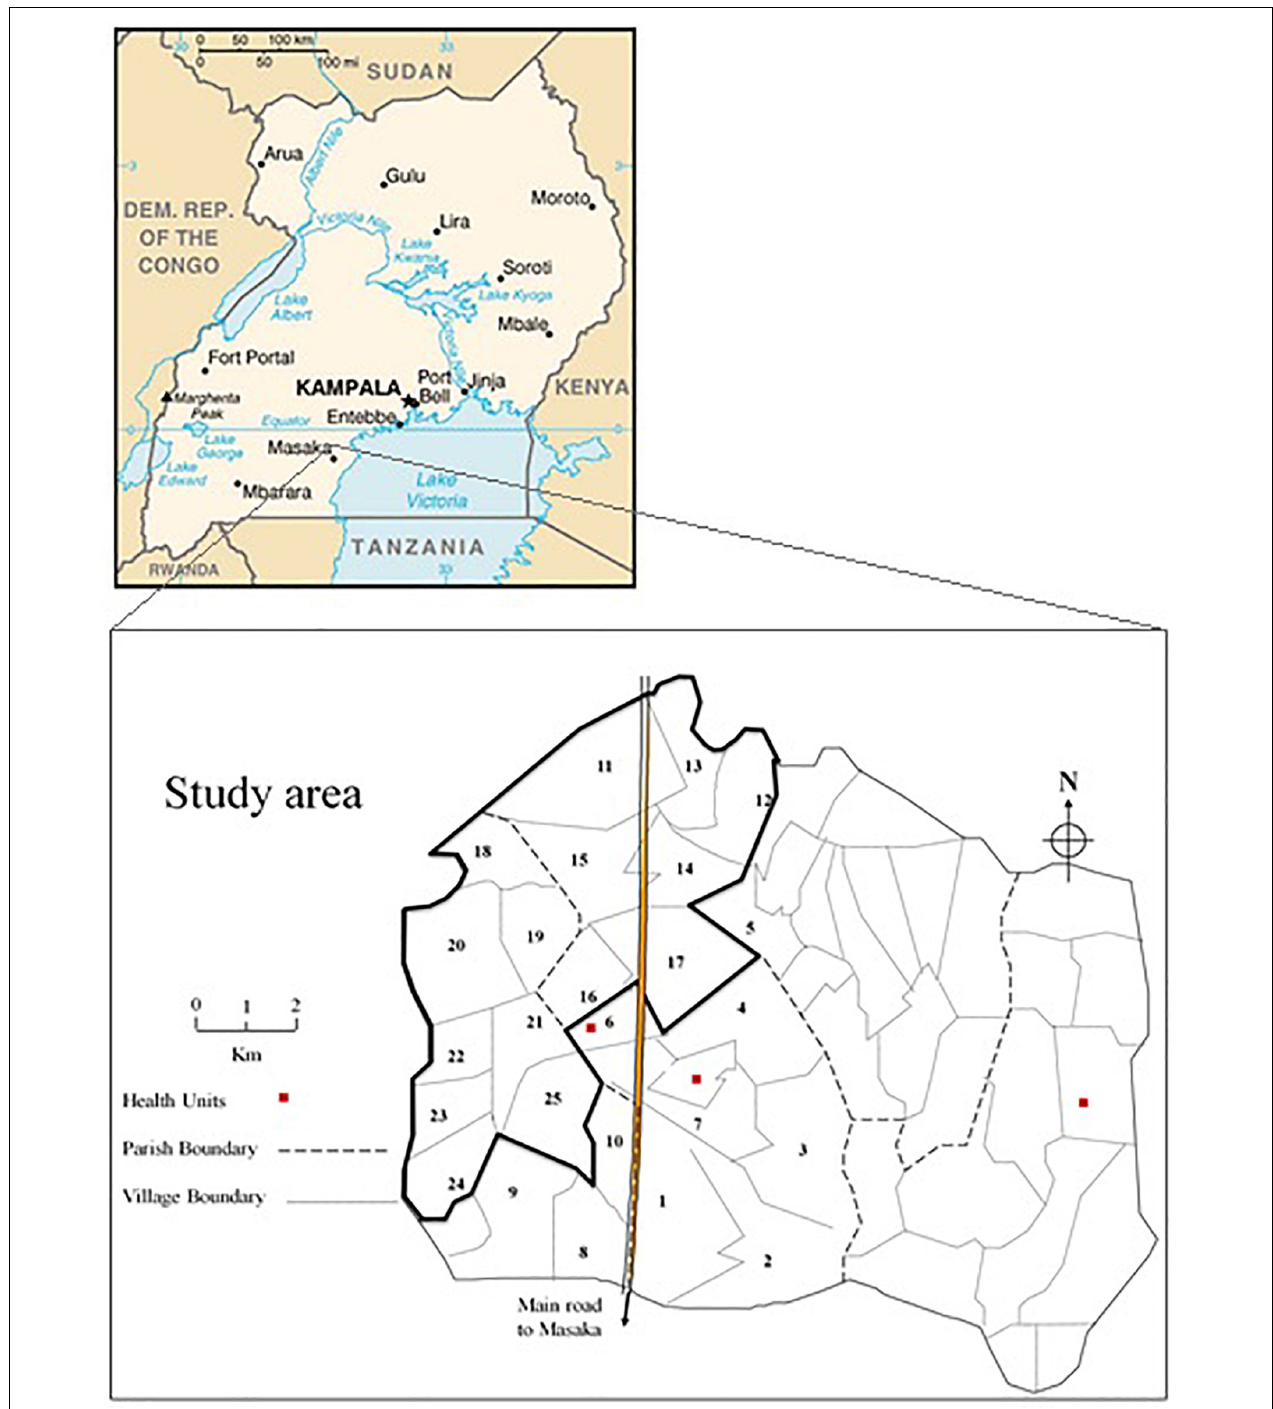
FIGURE 1 | Study area in Kyamulibwa